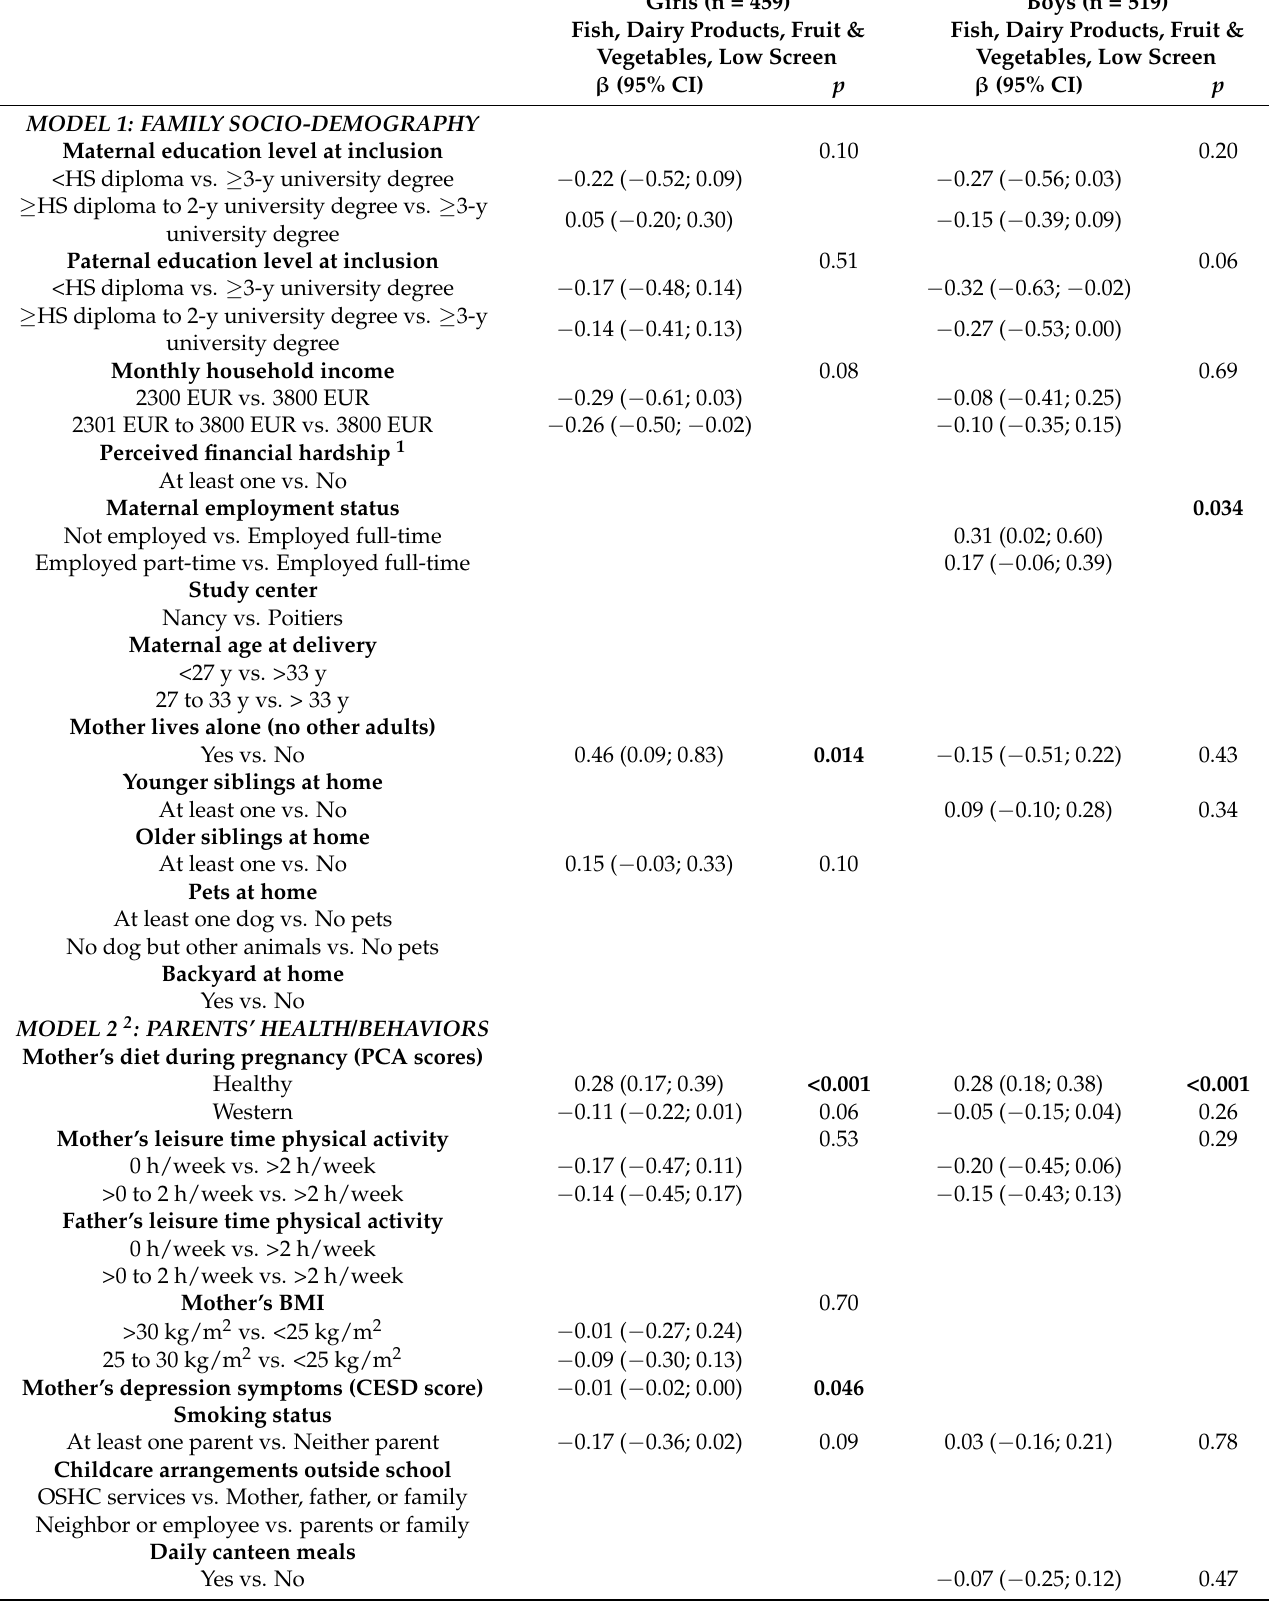
Table 4. Betas (95% CI) from multiply imputed and weighted hierarchical multivariable linear regression analyses, stratified by sex with healthy lifestyle pattern as the dependent variables. The EDEN